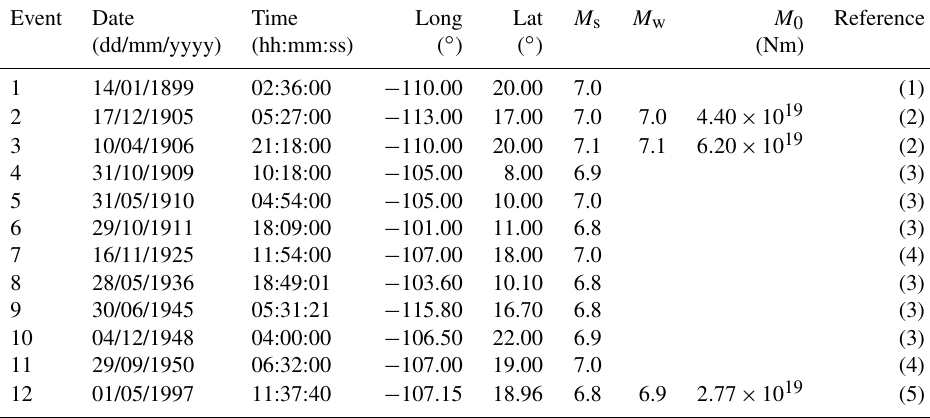
Table 1. Major oceanic earthquakes in Mexico ( M> 6 . 8).